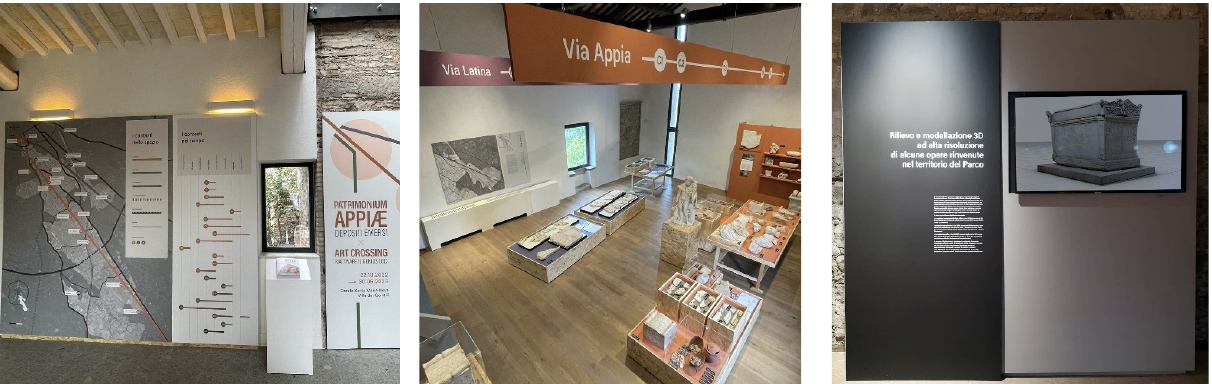
Figure 12. The exhibition ‘Patrimonium Appiæ Depositi Emersi’ and display installation realised for the sculptures. Source: Appia Antica Archaeological Park [84].